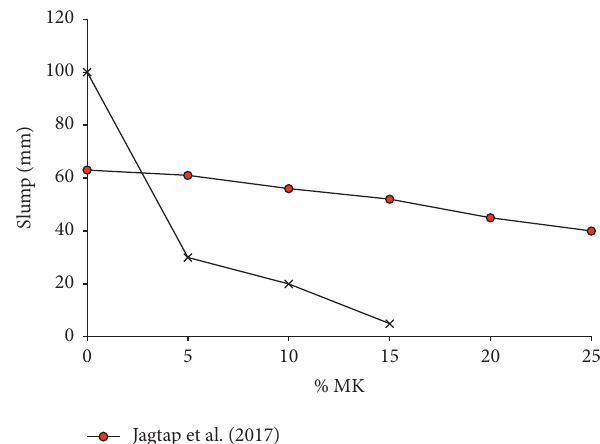
Figure 4: Effect of metakaolin on concrete workability [17,